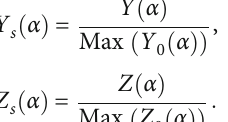
Table 2: The values of α Samples